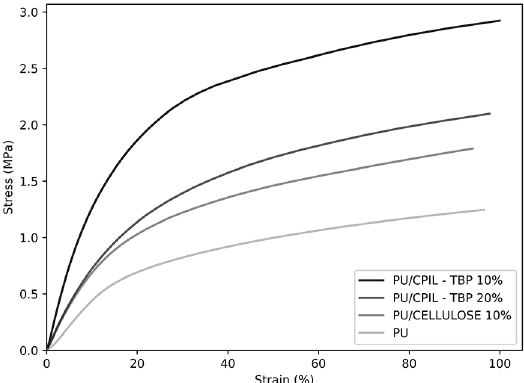
Figure 7. Stress/strain curves obtained for PU and PU composites.